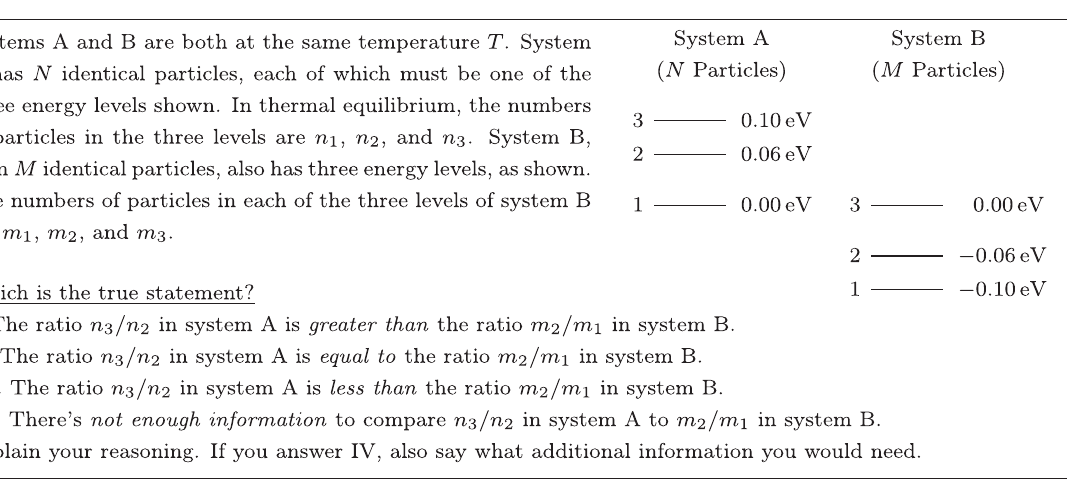
FIG. 4. PRQ Analog developed by instructor at school 2. Administered on a course exam once at school 1 and at school